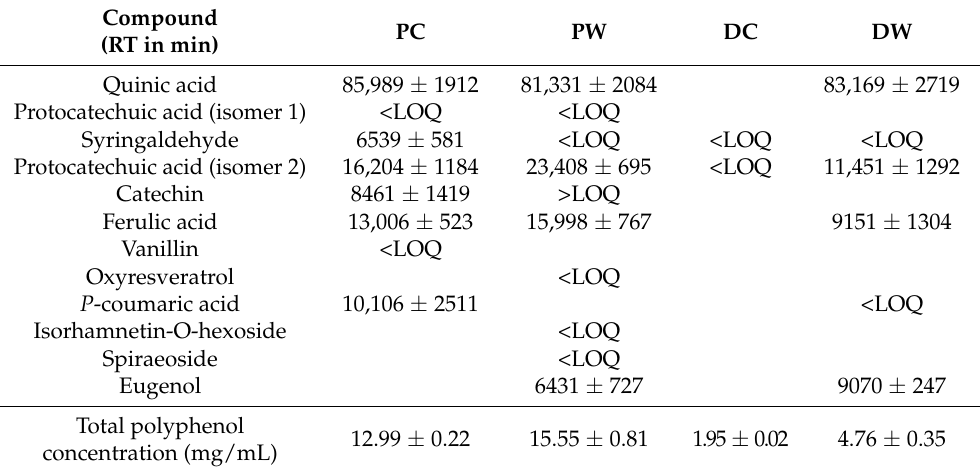
Table 4. Phenolic compounds found in debarking water (D) or bark press water (P) obtained from the pulp and paper industry using a clarifier (C) or wastewater treatment plant recycling (W). The quantities for each compound are given as peak areas. The total polyphenol concentration is given in